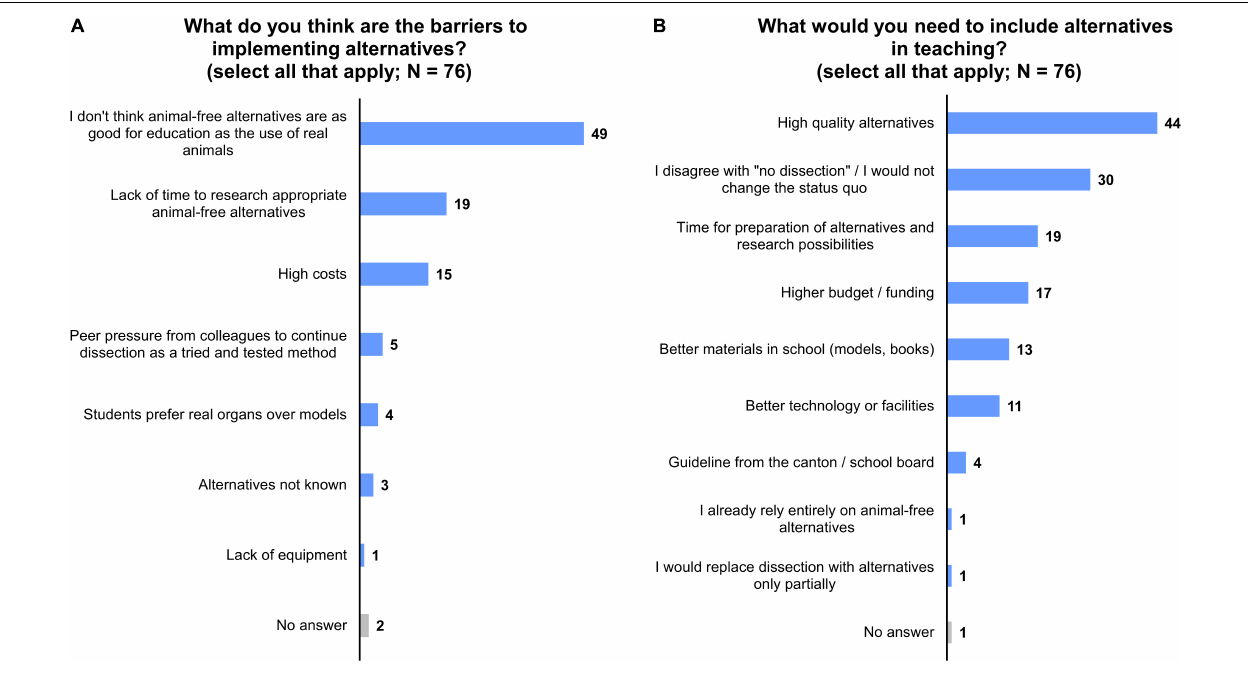
FIGURE 6 | (A) Perceived barriers to implementing animal-free alternatives instead of animal dissection. (B) Needs of the respondents that would have to be met in order to include animal-free alternatives in their teaching